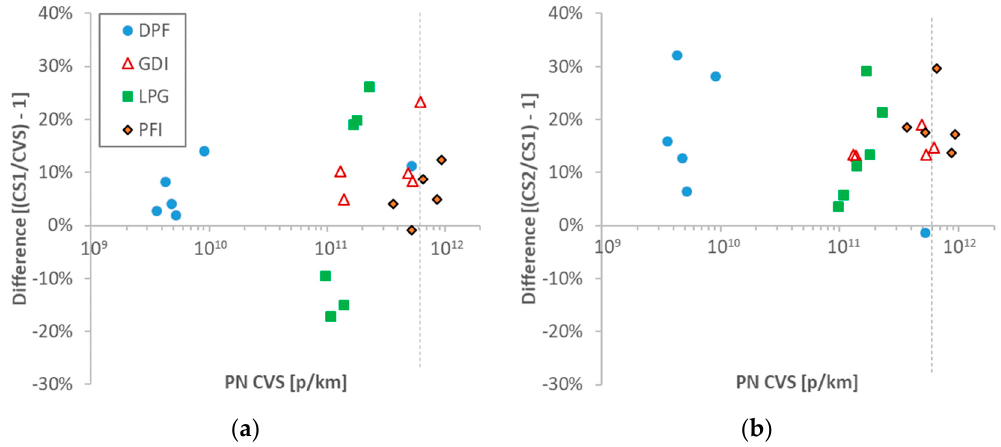
Figure 4. Comparisons of 10-nm particle number (PN) reference systems: ( a ) tailpipe versus dilution tunnel (CVS); ( b ) tailpipe CS1 versus tailpipe CS2. Each point is a test cycle. The dotted vertical lines show the laboratory PN emissions limit (for > 23 nm). CS = catalytic stripper; DPF = diesel particulate filter; GDI = gasoline direct injection; LPG = liquefied petroleum gas; PFI = port fuel